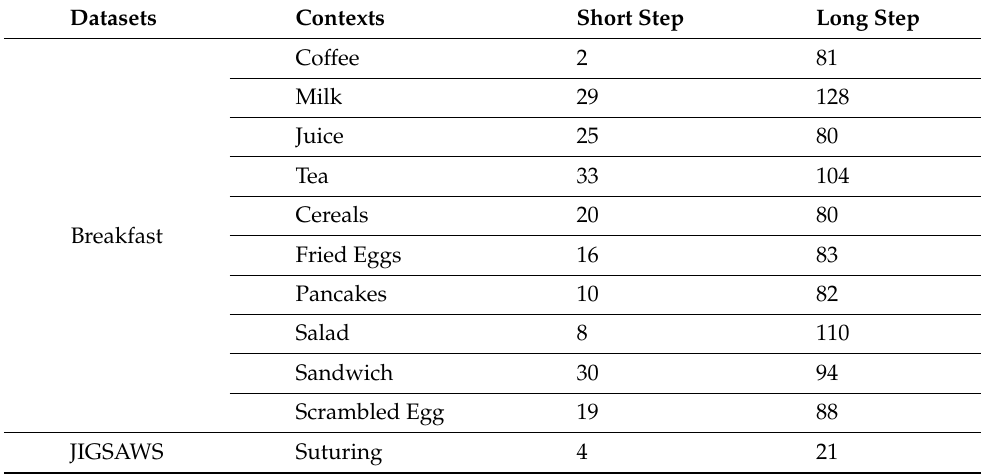
Table 2. RLN Steps